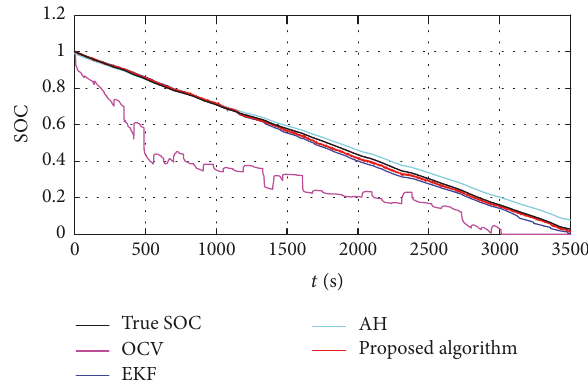
Figure 13: Comparison of SOC estimated by the proposed algo- rithm, EKF, AH counting method, and OCV method and true SOC tested by experiment under